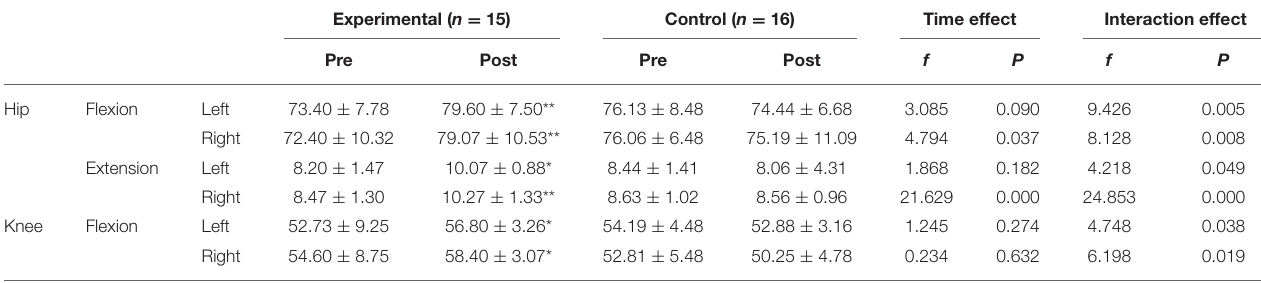
TABLE 3 | Joint range of motion outcome measures before and after 12 weeks of intervention.